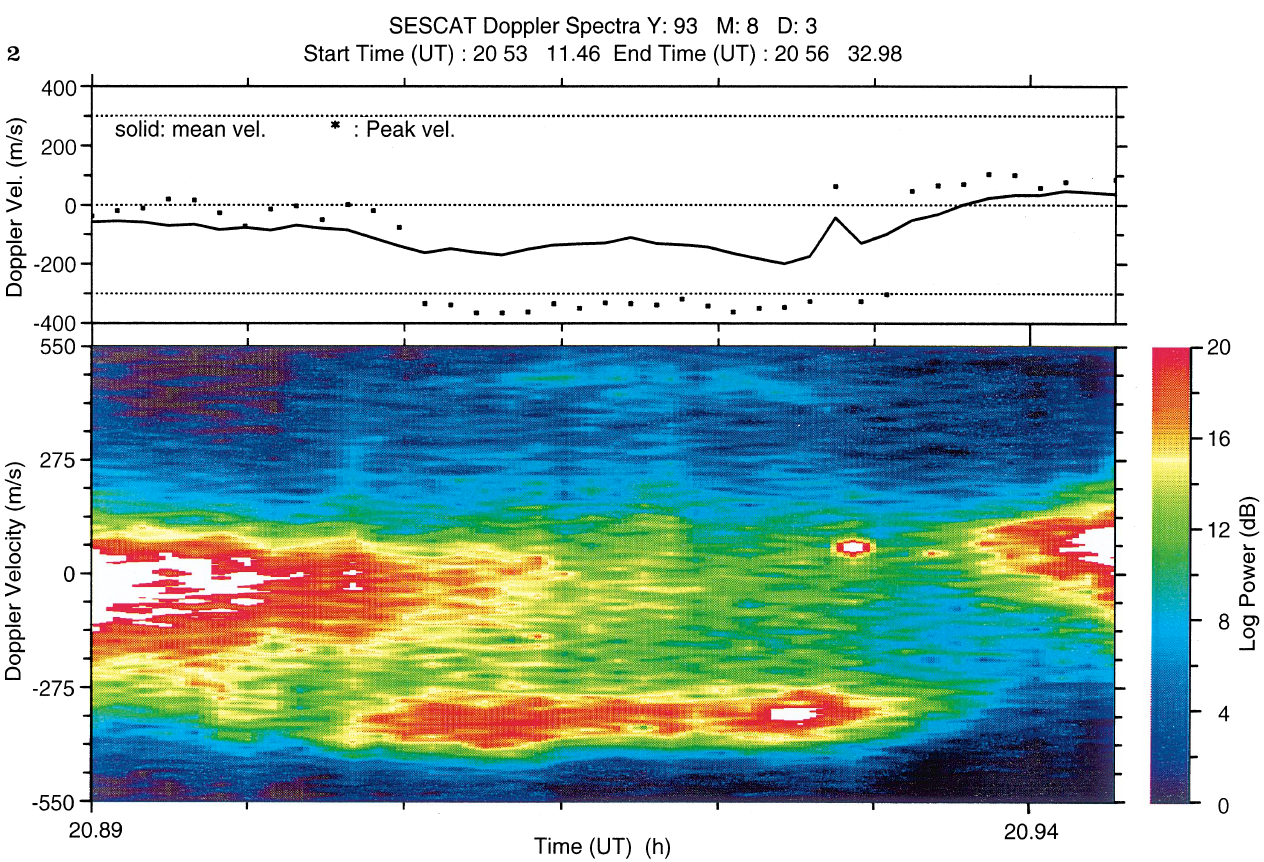
narrow spectrum with a peak velocity of about ) 360 m/s (northward). A very weak belt of scatter is also seen concurrently at positively shifted velocities somewhat above